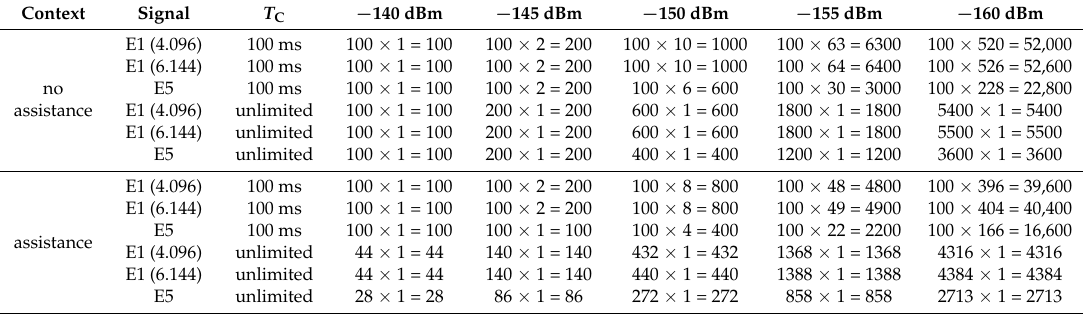
Table 17. Total integration time T IT = T C × N NC as function of the sensitivity and context with Galileo signals, for worst losses. Note that the sensitivities given are for the L1 C/A signal; those of E1 are 1.5 dB lower and those of E5 are 0.5 dB